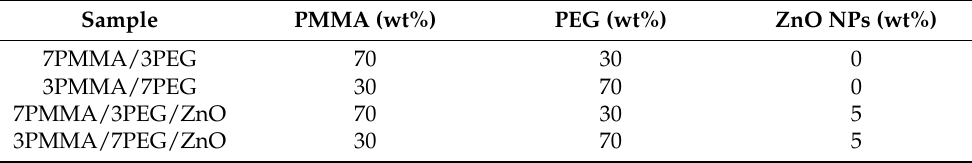
Table 1. Polymer blends and nanocomposite films used in this study.